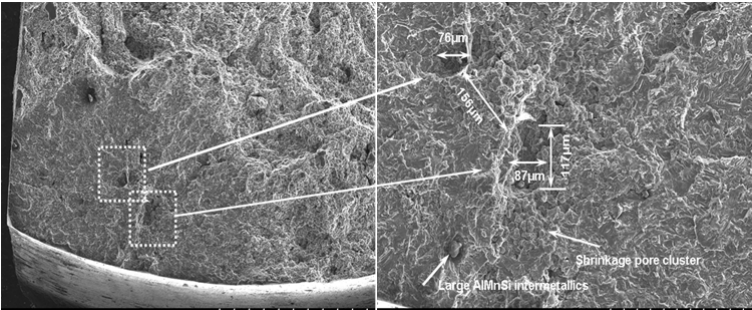
Figure 12. SEM image of a crack initiation site in specimen 42-26 (Fatigue life = 120,632 cycles)